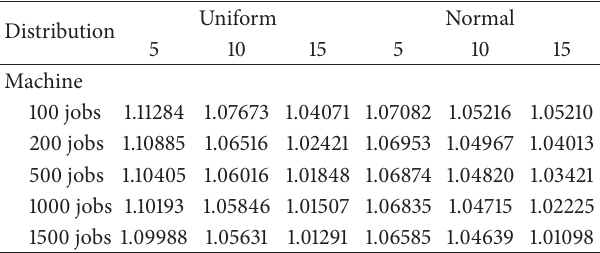
Table 1: Results of SPT/LB(3).